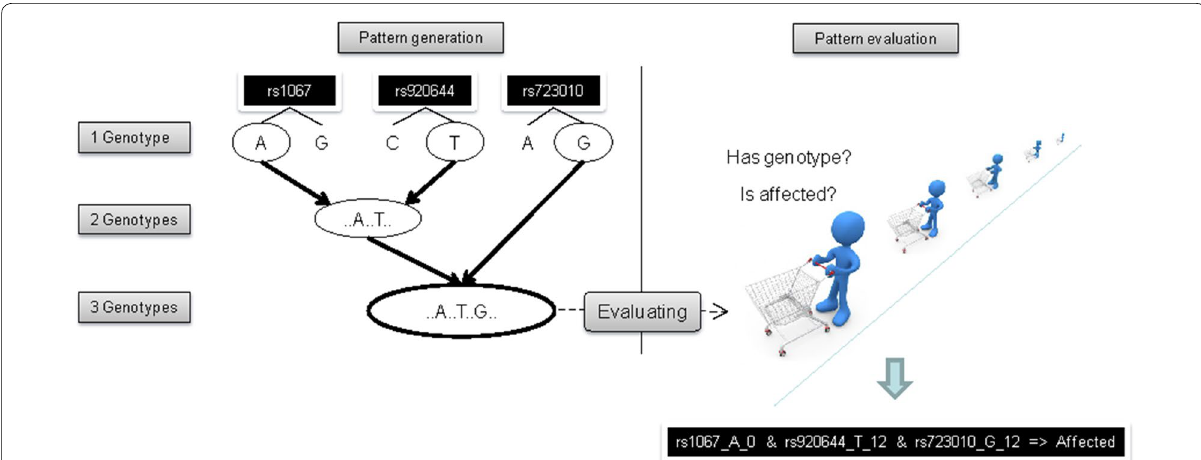
Fig. 2 Illustration of the implemented version of the association rule mining algorithm. The lattice shown left is traversed starting from root {} to all leaves. Each genotype pattern (node in the tree) represents a subgroup of patients shown in the genotype matrix G. Additionally, using the p phenotype information of the patients from matrix P, we can count genotype and phenotype occurrences in contingency tables. Here illustrated for the genotype pattern g 1 g 2 g n with ‘a’ counting all patients where genotype g 1 g 2 g n and phenotype p i are present, ‘d’ were neither of both are present, and ‘b’ and ‘c’ counting patients with presentation of genotype g 1 g 2 g n but not phenotype p i and visa versa. The lattice is traversed as long as there are unprocessed genotype patterns that cannot be pruned